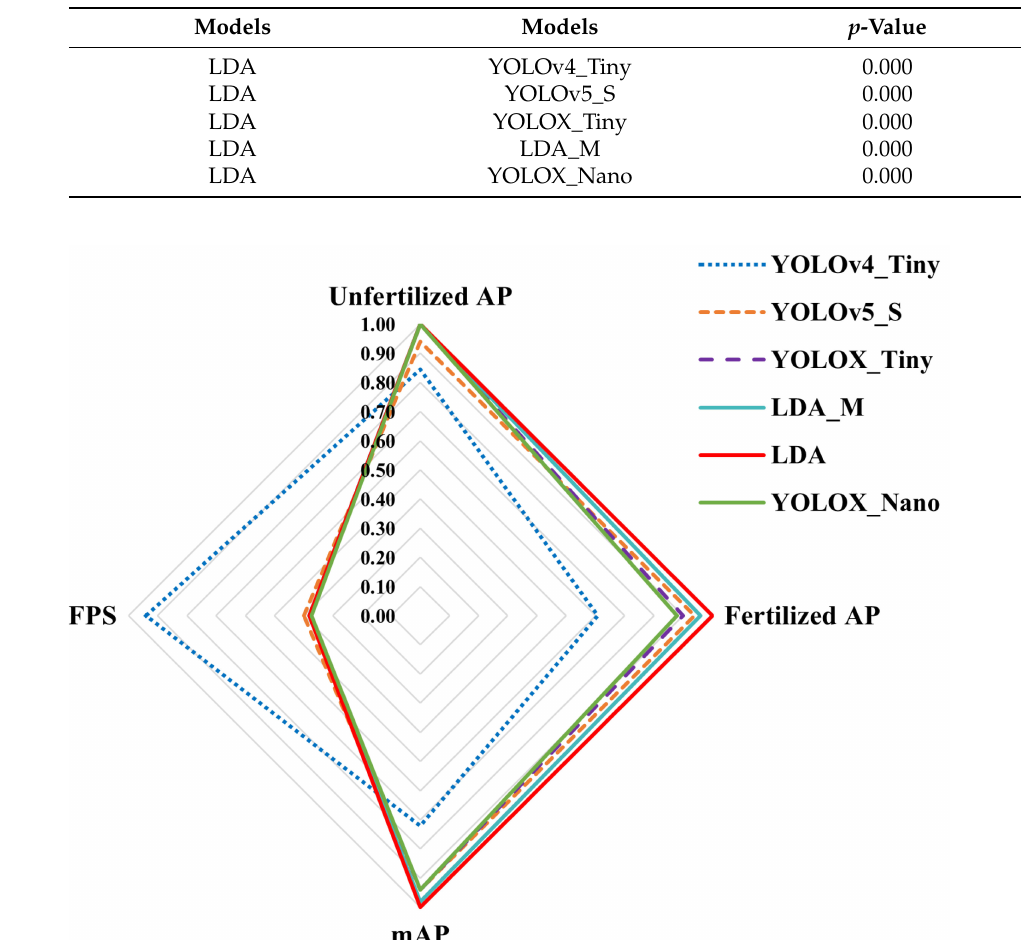
Table 9. One-way ANOVA with mAP for different models.